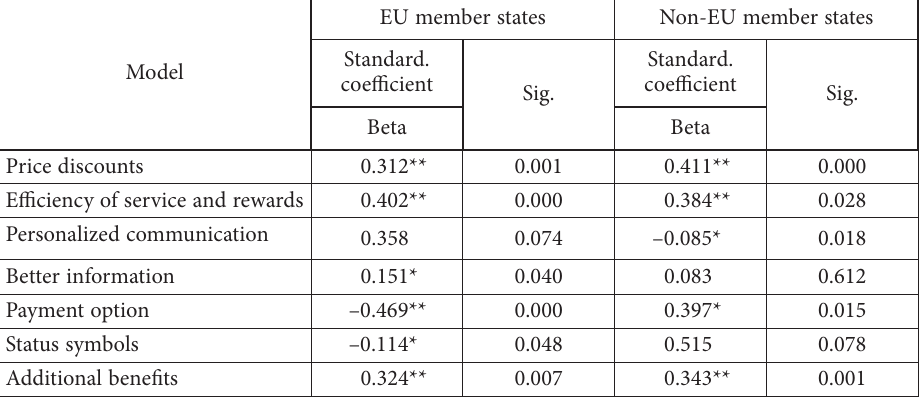
Table 6. Contribution of individual indicators to description of criterion variable in groups of EU/ non-EU countries EU member states Non-EU member states Standard. Standard. Model coefficient Sig.